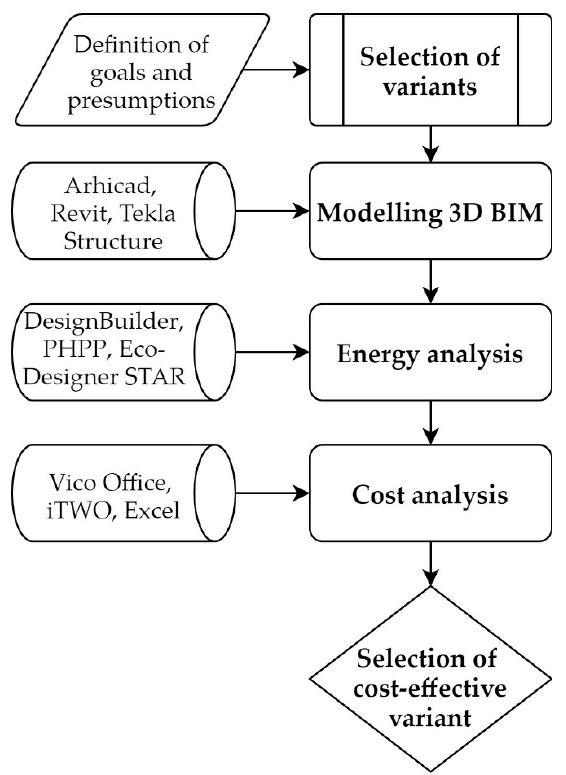
Figure 1. A systematic approach for energy and cost analysis of the building envelope components using building information modelling (BIM).